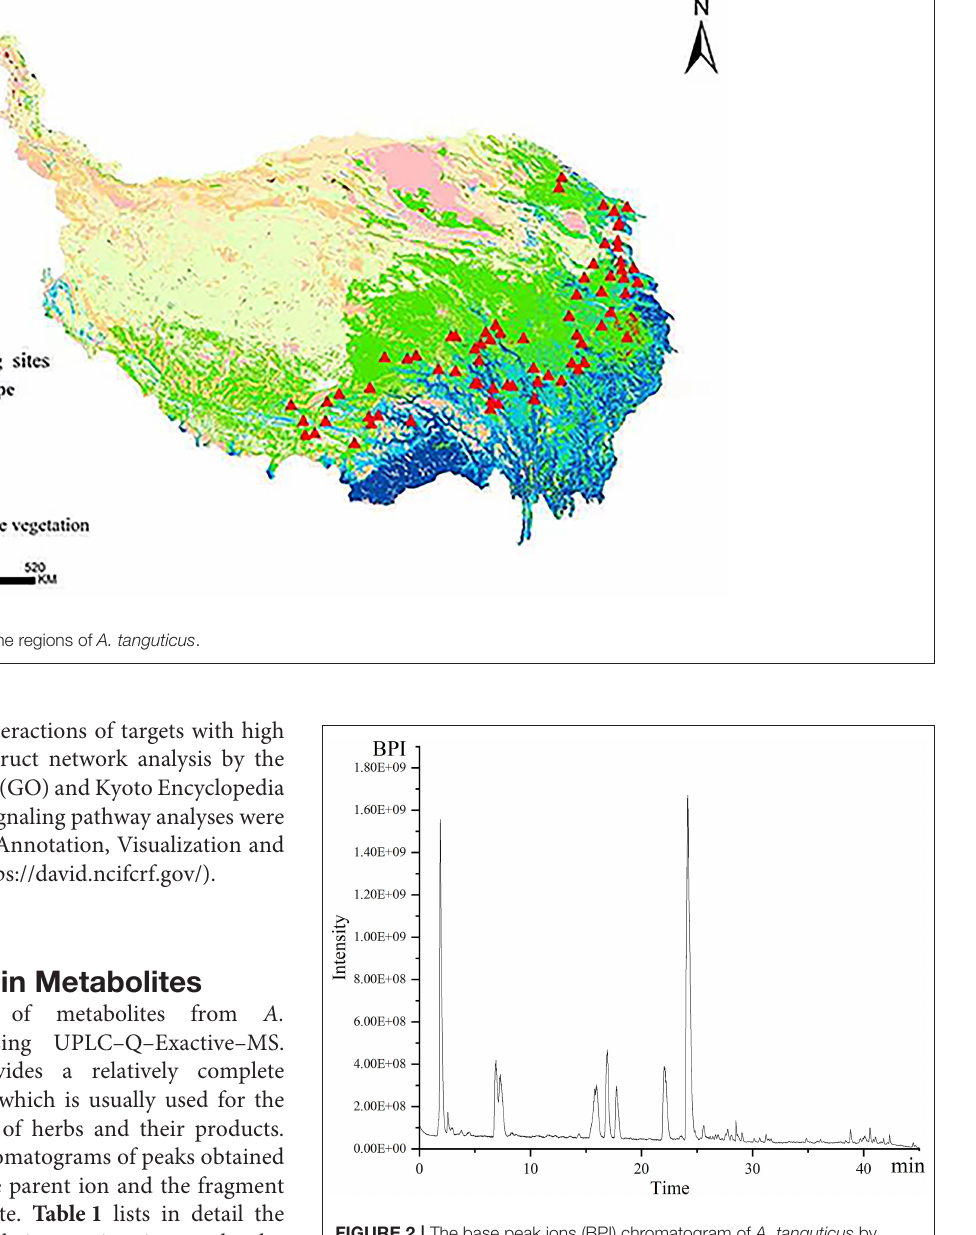
FIGURE 2 | The base peak ions (BPI) chromatogram of A. tanguticus by UPLC–Q–Exactive–MS in positive ion